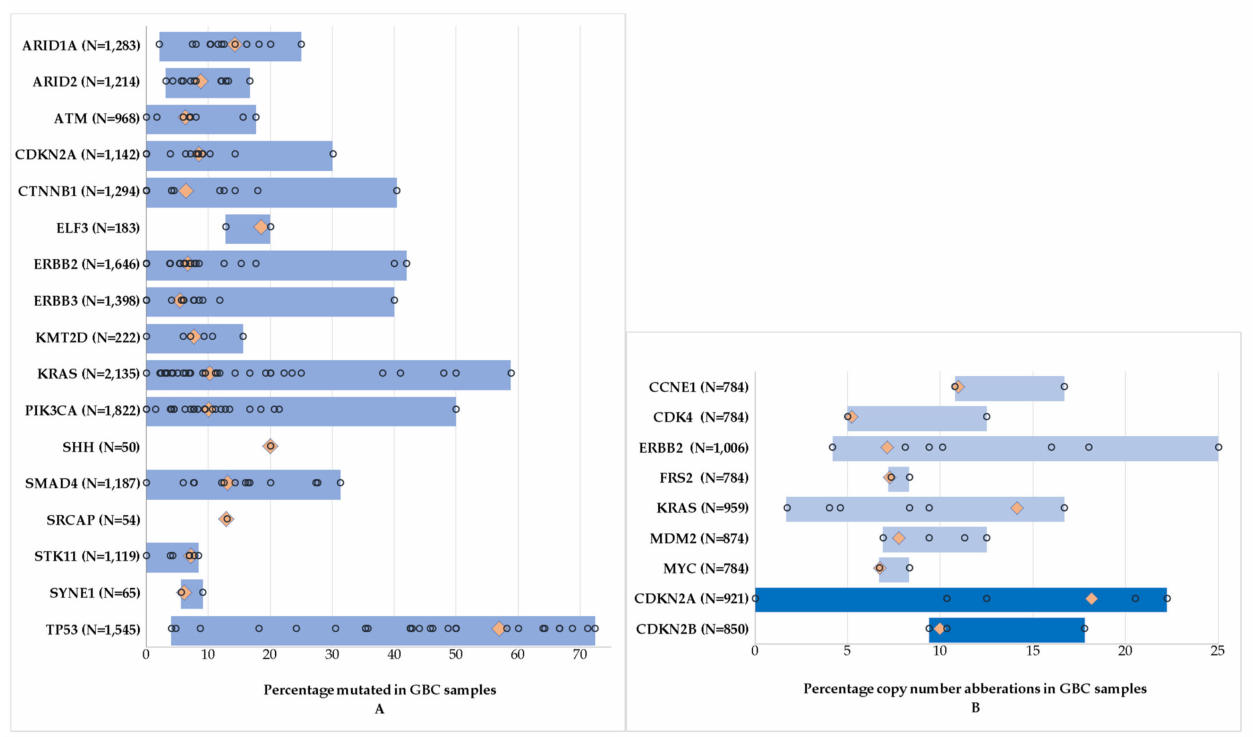
Figure 2. Frequently occurring genetic alterations (>5% across all studies and in >5 of all included samples) in gallbladder cancer. Numbers represent the total number of samples tested for this gene. Blue bars represent the minimum and maximum reported alteration frequencies. Dots represent the mutation frequency per study. Orange diamonds represent the weighted average of all frequencies. ( A ) Gene mutations. ( B ) Gene amplifications (light blue) and gene deletions (dark